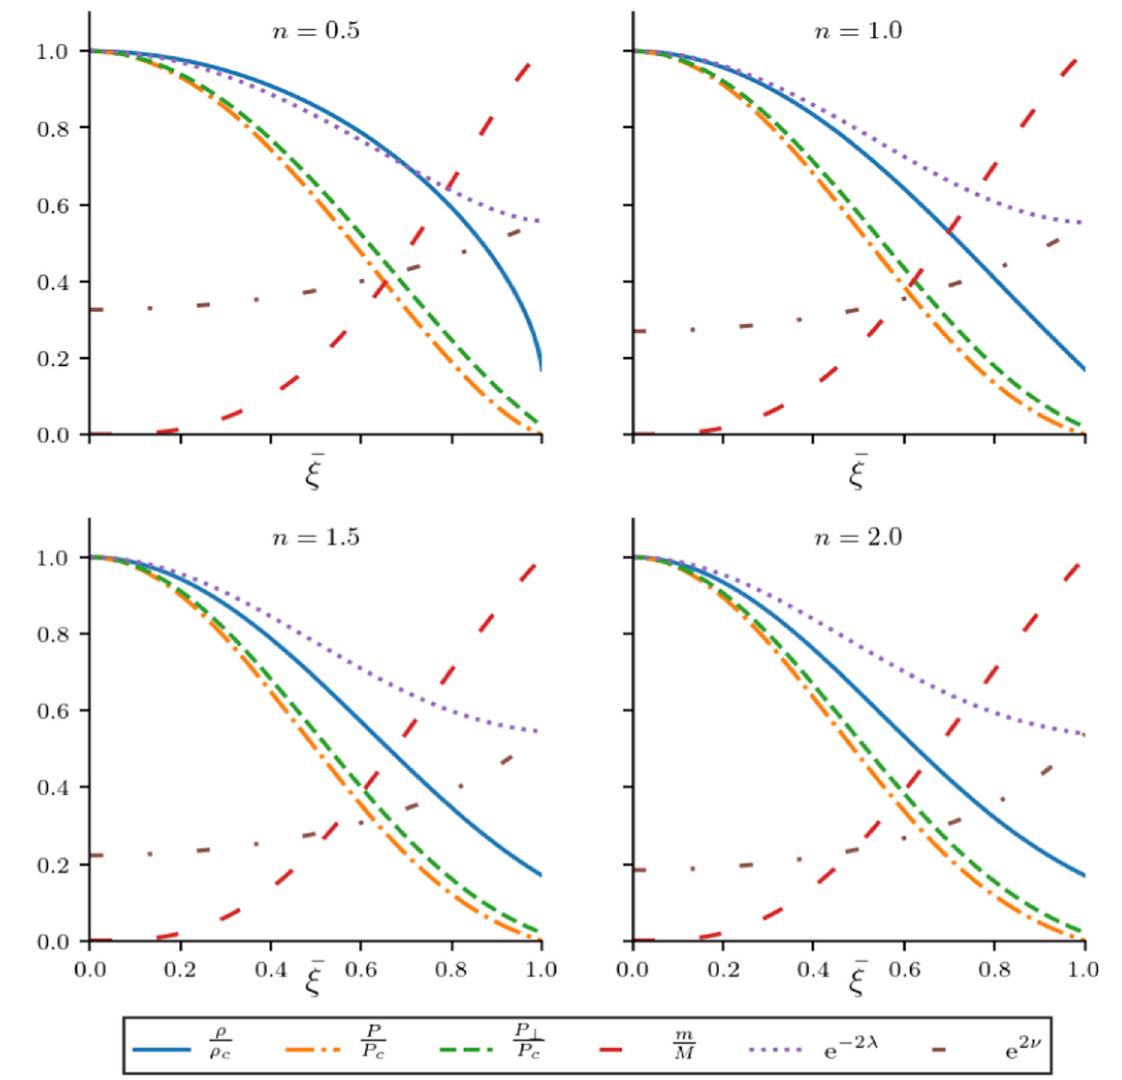
Fig. 2 Physical variables (density, radial/tangential pressures, mass) and metric coefficients within matter configuration for the numeric solution of the Lane–Emden master equation. They are displayed as functions of ¯ ξ for models having α = − 0 . 01, (cid:18) = 0 . 17, C = 0 . 05, σ = 0 . 175, for several values of n . The metric potentials are not singu-